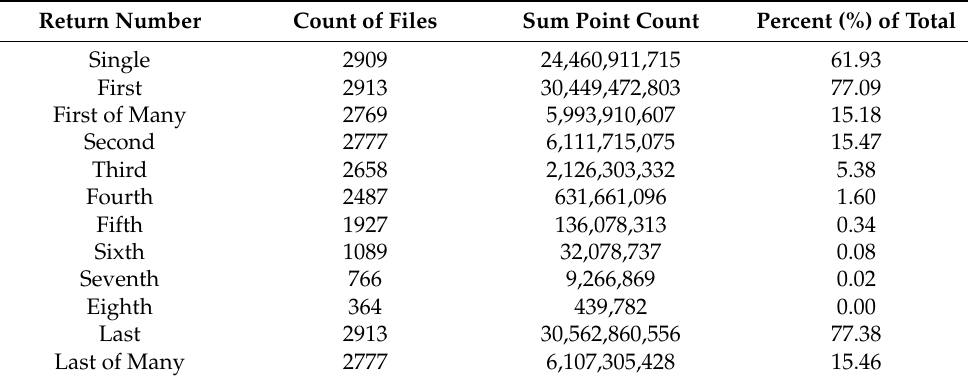
Table 10. Composition of returns from stratified random sample approach.